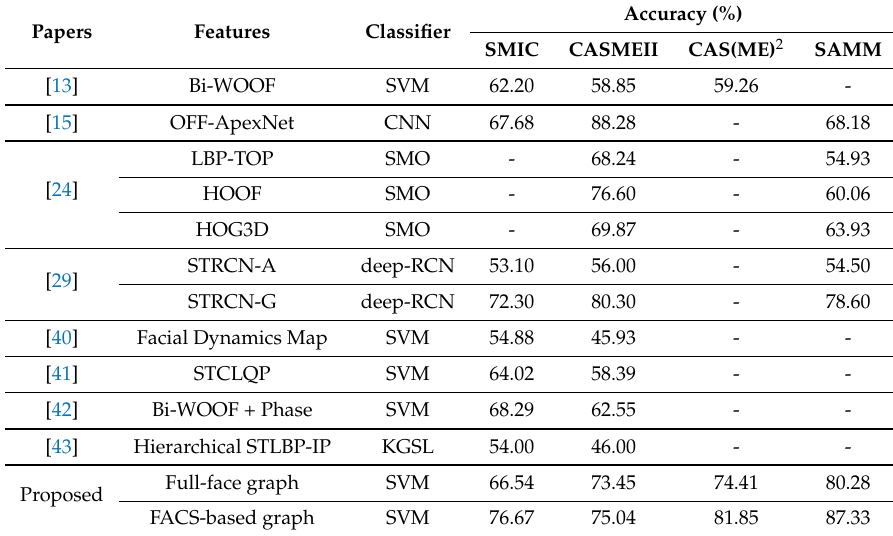
Table 7. LOSOCV: Accuracy of the proposed algorithm vs other methods.